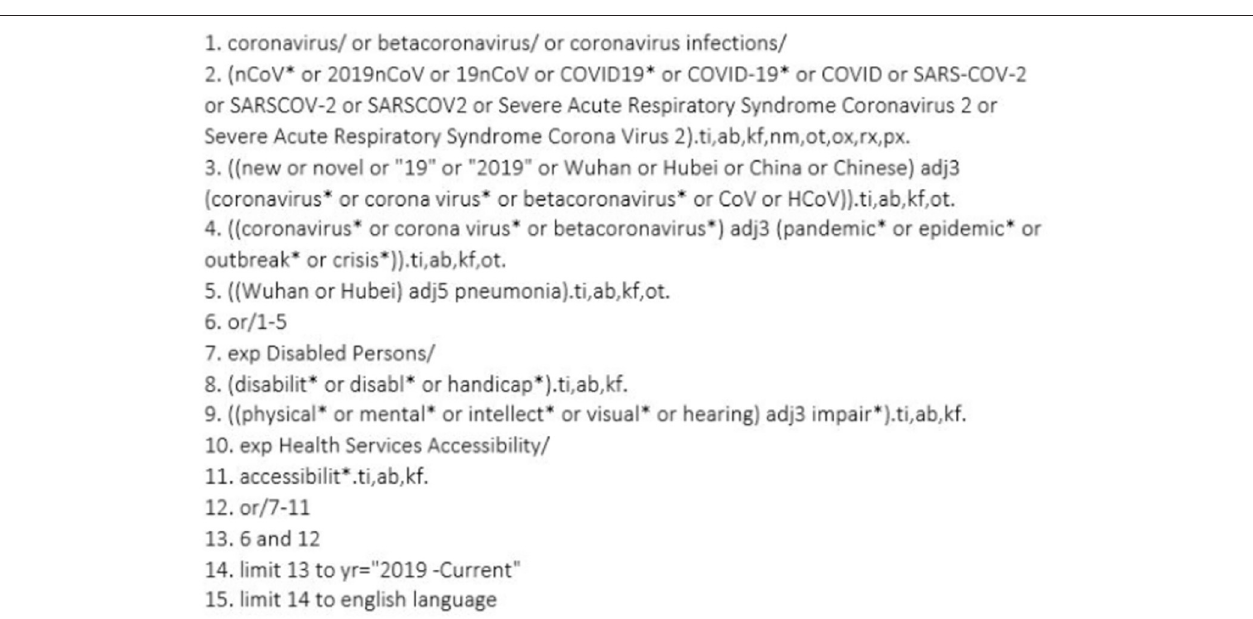
FIGURE 1 | Full search strategy used on database Medline (Ovid). #1-5 are referring to articles containing coronavirus and all varying modifications to the term. #7-11 denote articles containing disability, accessibility and all varying modifications to the terms. Finally, #12 and #13 are a combination of the above concepts, while #14 and 15 are limiting the search by year and English